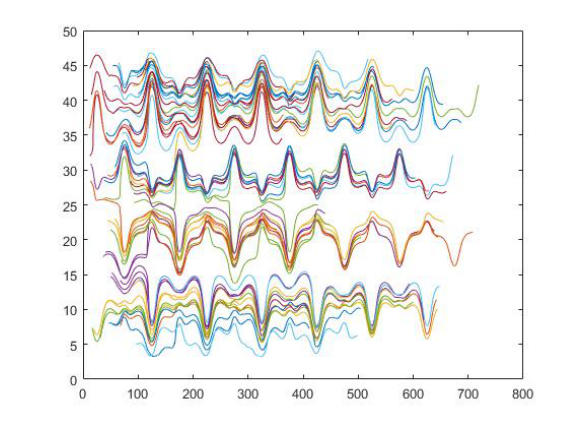
Fig. 13. Geometry A50, the position of the Y-coordinates of the cells’ centre depending on X-coordinate.